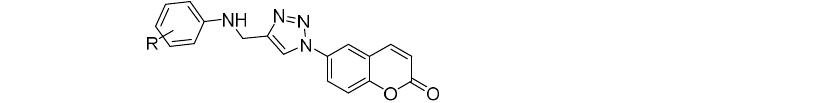
Figure 2. SAR of coumarin-linked 4-anilinomethyl-1,2,3-triazoles.